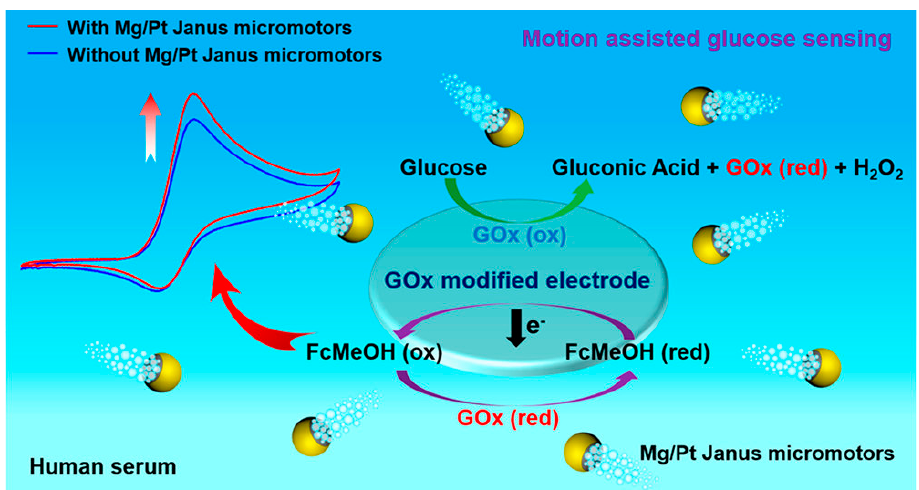
Figure 10. Schematic Representation of magnesium/platinum-based Janus micromotor assisted glucose biosensor in human serum using screen printed electrode. Reproduced with permission from Kong et al. (2019), ©American chemical society (ACS), 2019 [105].